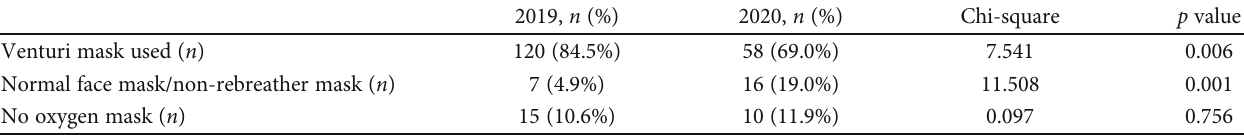
Table 2: Oxygen treatment received in AECOPD inpatients during the study period.